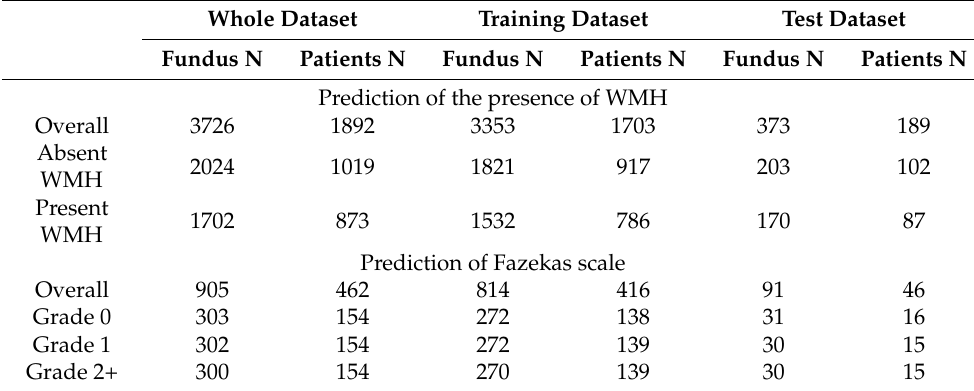
Table 1. Composition of the fundus photograph